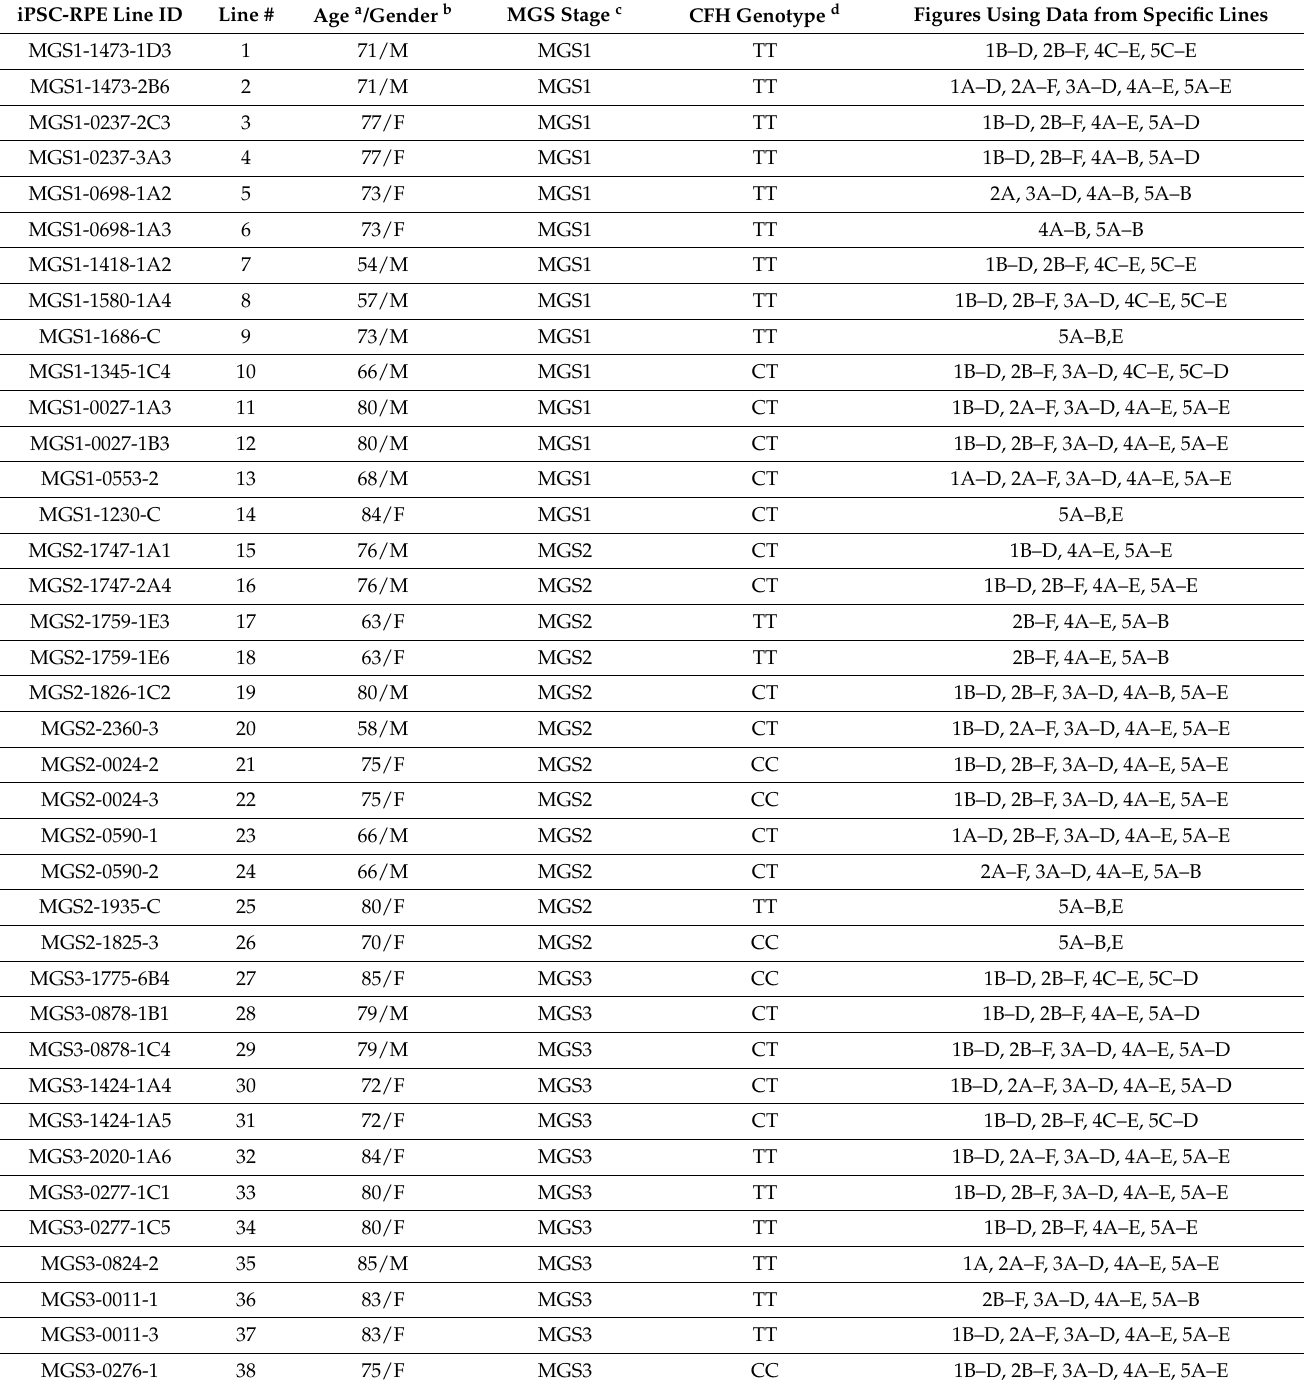
Table 1. Description of iPSC-RPE lines and donor